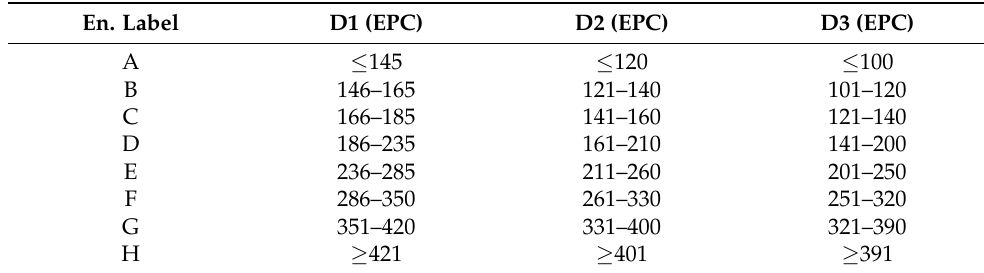
Table 2. Estonian energy labels for the three categories of detached houses D1, D2, and D3; EPC (kWh/(m 2